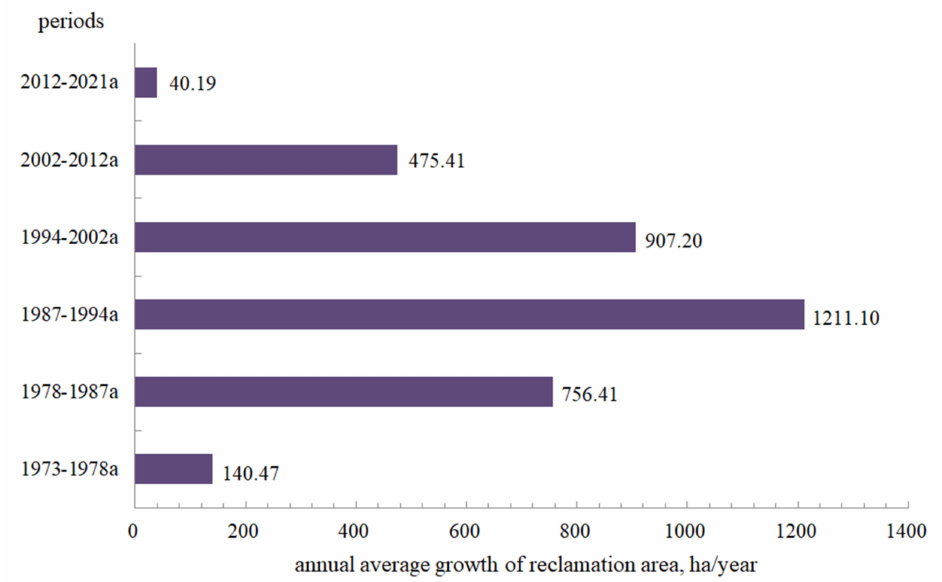
Figure 5. Average annual reclamation